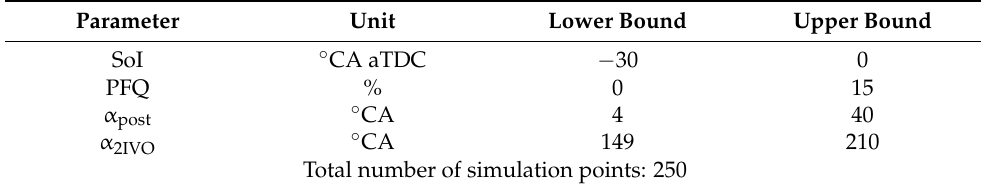
Table 3. Latin Hypercube DoE